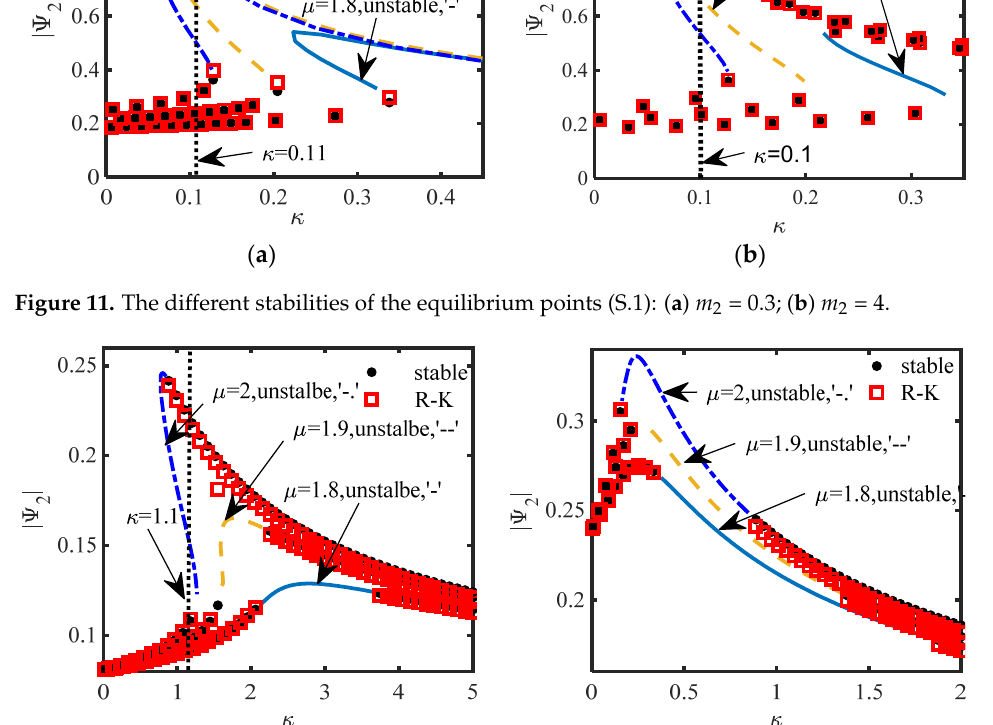
Figure 12. The different stabilities of the equilibrium points (S.2) ( a ) c s = 0.3; ( b ) c s = 0.1.